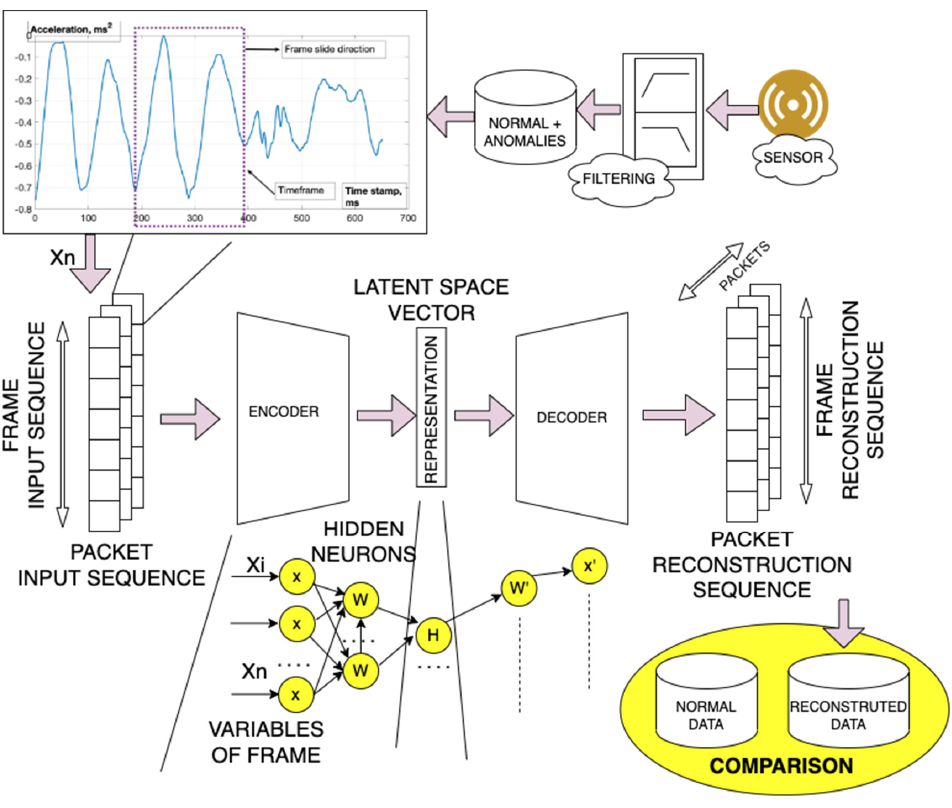
Figure 5. Demonstration of the use case